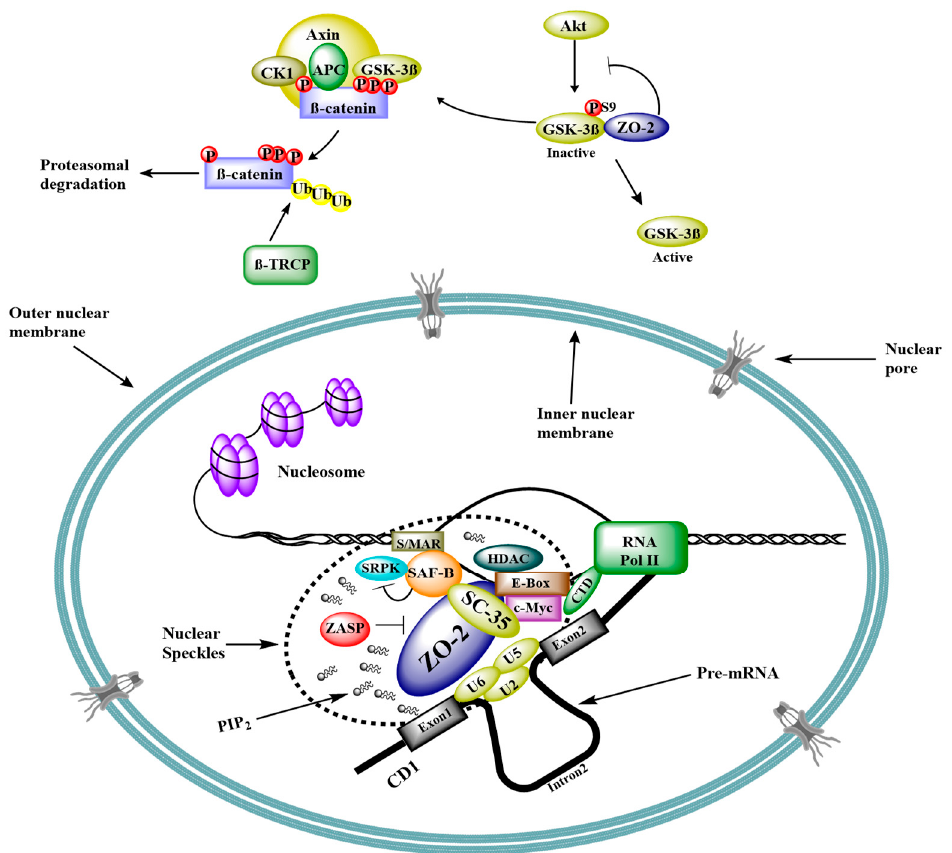
Figure 3. Schematic diagram of ZO-2 as a scaffold for transcription and splicing. ZO-2 expression blocks GSK-3 β inhibitory phosphorylation at Ser9. GSK-3 β phosphorylates β -catenin and targets it for ubiquitination and proteasomal degradation. Consequently, β -catenin entry into the nucleus and transcriptional activity is inhibited. At the nucleus, ZO-2 localizes in speckles associated to PIP2 and ZASP and inhibits transcription of CD1 through its interaction with an E-box in the promoter region, mediated by c-Myc transcription factor. In addition, ZO-2 is proposed to participate in mRNA splicing due to its association with the essential splicing protein SC-35 and the scaffold attachment factor SAF-B. S/MAR, scaffold/matrix attachment región; P, phosphate; Ub, ubiquitin; U2, U5, and U6, splicing ribonucleoproteins; PIP2, phosphatidylinositol (4,5)-bisphosphate.